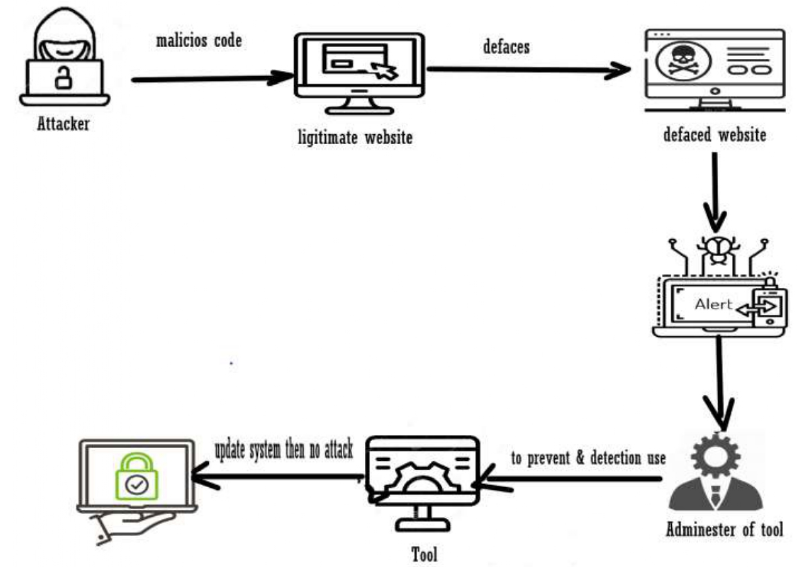
Figure 9. How tools work to detect and prevent website